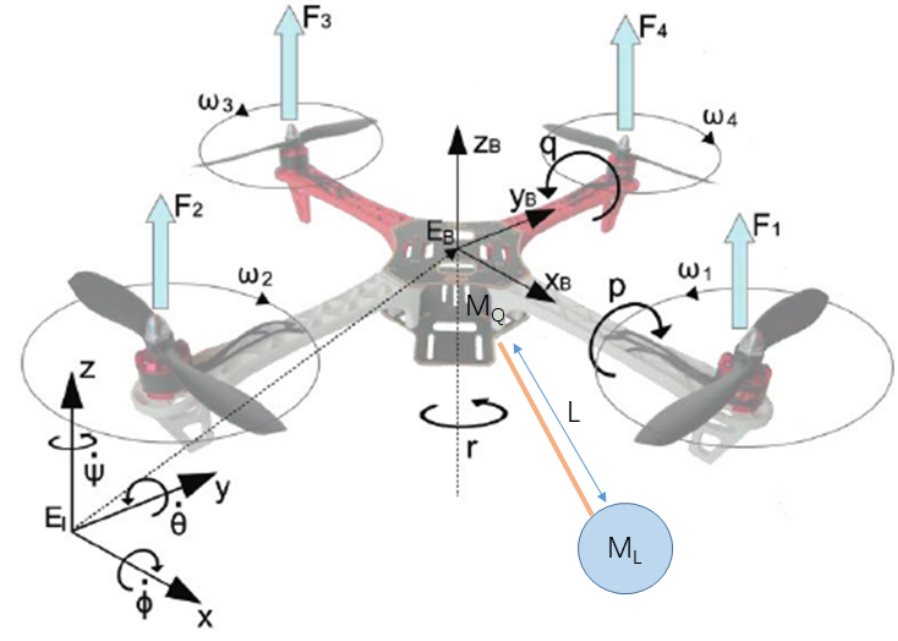
Figure 1. The “X” type of quadrotor